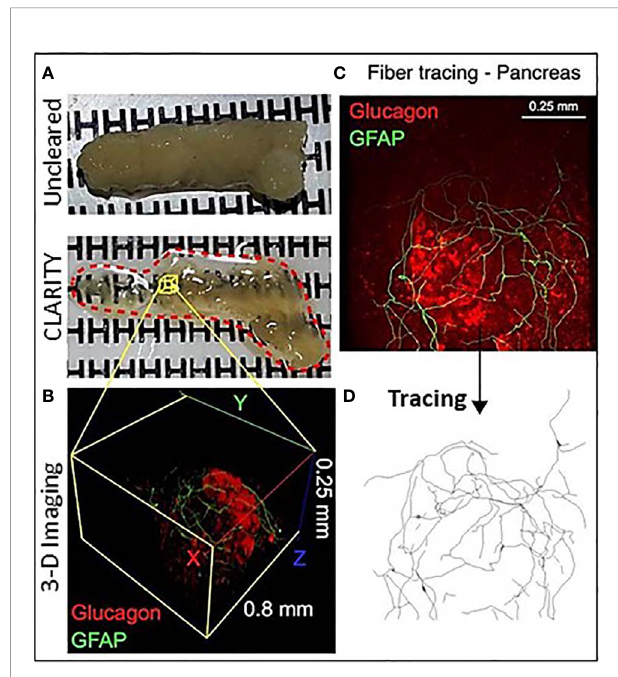
FIGURE 1 | Optical clearing of human pancreas by PACT and iDISCO. (A) Fixed pancreas sample from a control donor before and after clearing using passive CLARITY (PACT) showing the degree of sample transparency achieved with this method. (B) Representative example of 2-photon imaging for a 0.8 mm x 0.8 mm x 0.25 mm region (X, Y, Z axes) containing an islet immunostained for glucagon (red) and glial fi brillary acidic protein (GFAP, green). (C) GFAP-stained Schwann cells overlay an islet and cell projects were analyzed using the ImageJ neurite tracer program. (D) The traced Schwann cells are shown by Neurite tracer skeleton